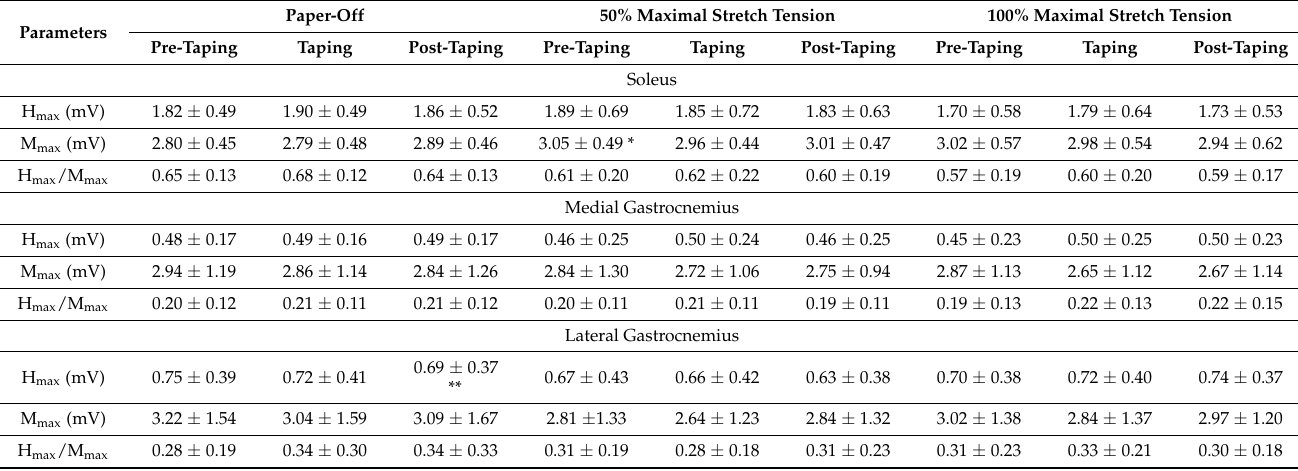
Table 3. Modulation of soleus, medial, and lateral gastrocnemius H-reflex during paper-off, 50%, and 100% of maximal kinesiology taping stretch tensions in pre-taping, taping, and post-taping conditions.